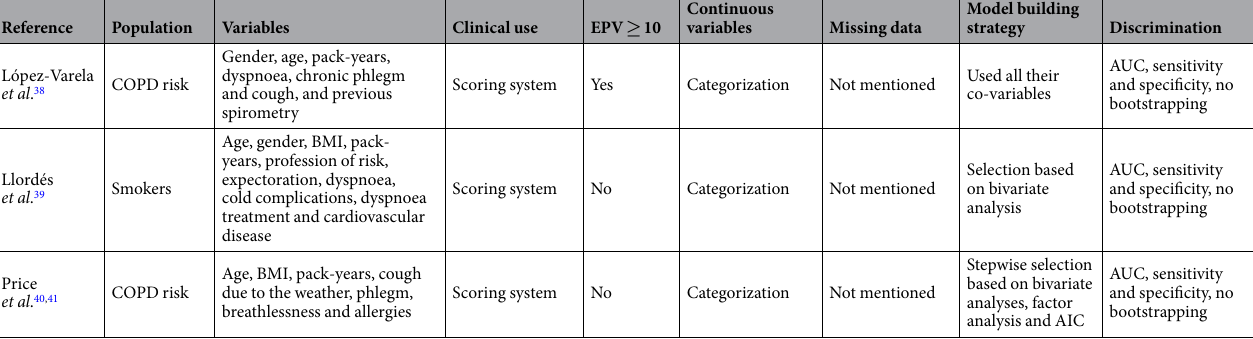
Table 1. Analysis of the published studies that developed a predictive model to diagnose chronic obstructive pulmonary disease in risk populations (screening). Abbreviations: A.I.C., Akaike’s Information Criterion; A.U.C., area under the receiver operating characteristic curve; B.M.I., body mass index; C.O.P.D.,